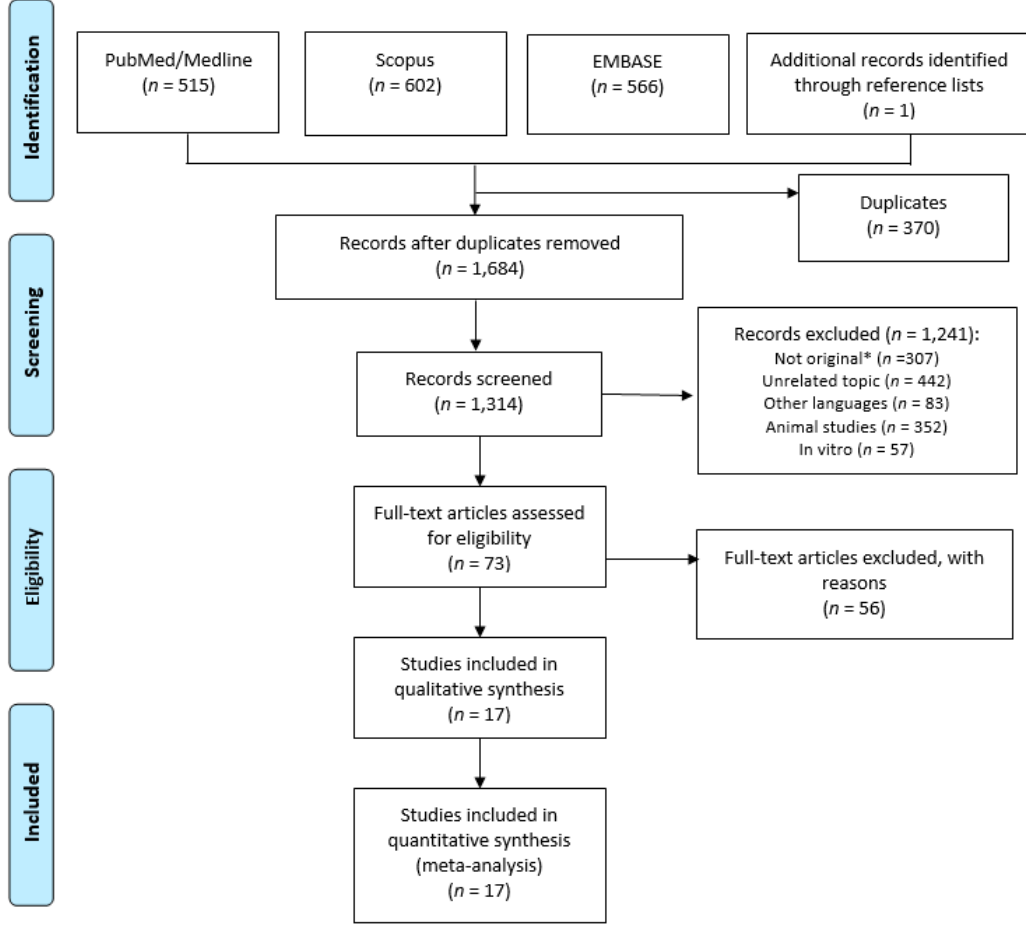
Figure 1. Flow diagram of the selection process. From: Moher D, Liberati A, Tetzlaff J, Altman DG, The PRISMA Group (2009). Preferred Reporting Items for Systematic Reviews and Meta-Analyses: The PRISMA Statement. PLoS Med 6(7): e1000097. doi:10.1371/journal.pmed1000097 [35].